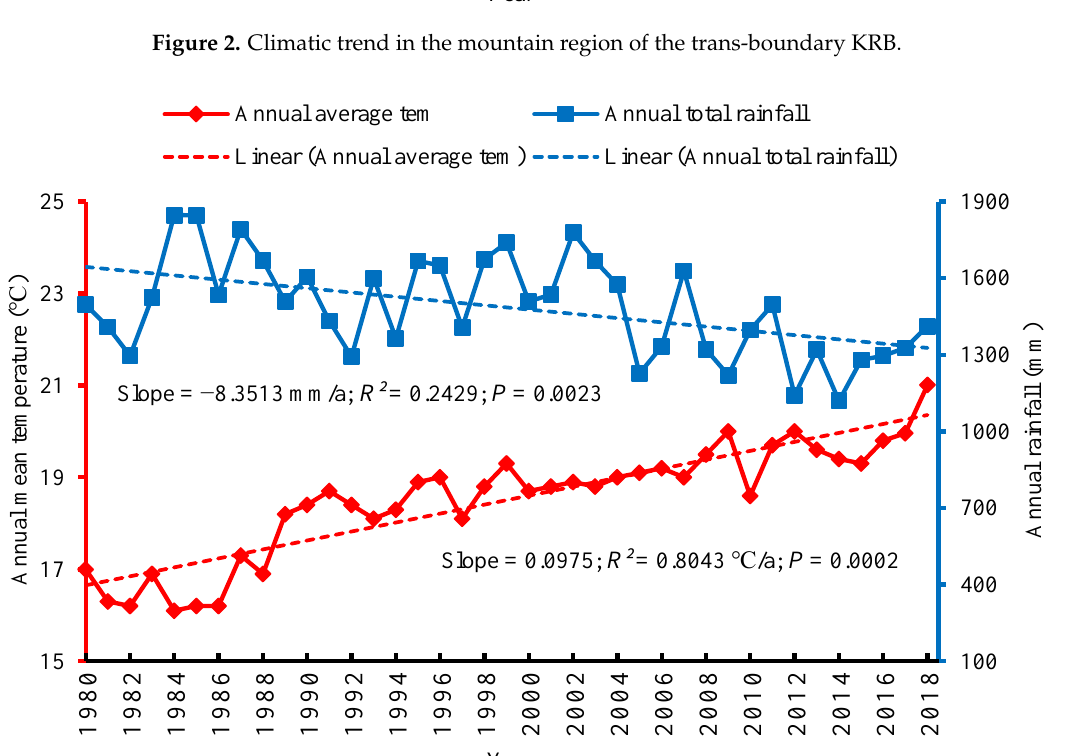
Figure 3. Climatic trends in the hill region of the trans-boundary KRB. With respect to the Tarai region of the KRB, it was found that the mean annual tem- perature also showed an increasing trend by 0.0187 °C/a between 1980 and 2018. The in- creased rate of temperature for this region was significantly less than the mountain and hill regions of the basin. Furthermore, the rise in temperature trend in Tarai region also positively correlated with a p value of 0.0206 (Figure 4).